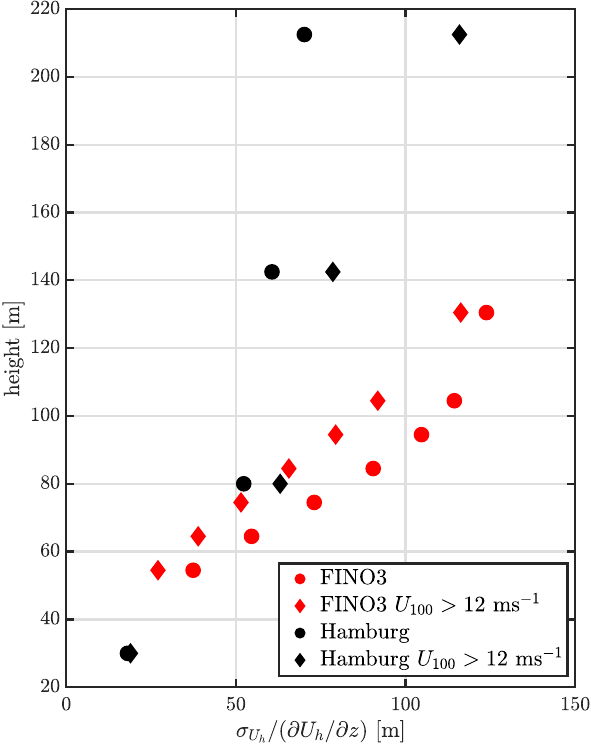
Figure A1. The behavior with height of the ratio of the standard deviation of the wind to the vertical wind shear under onshore (black markers) and offshore (red markers) conditions within the selected wind sector. Circles represent median values of all data and diamonds are median values for wind speeds higher than 12 m s − 1